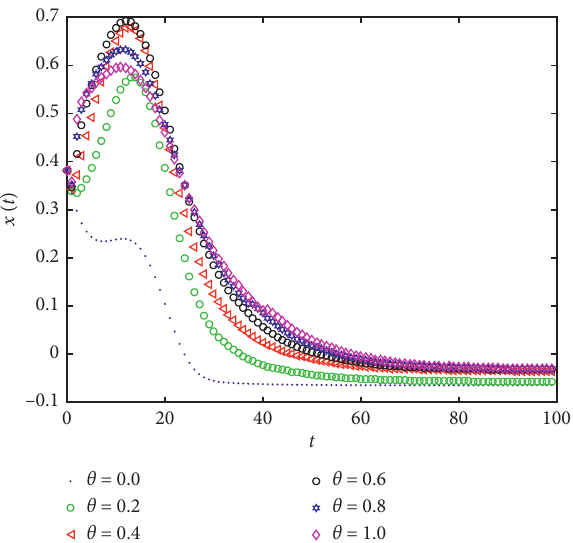
Figure 17: Evolution of average collective opinions based on different influence powers of opinion